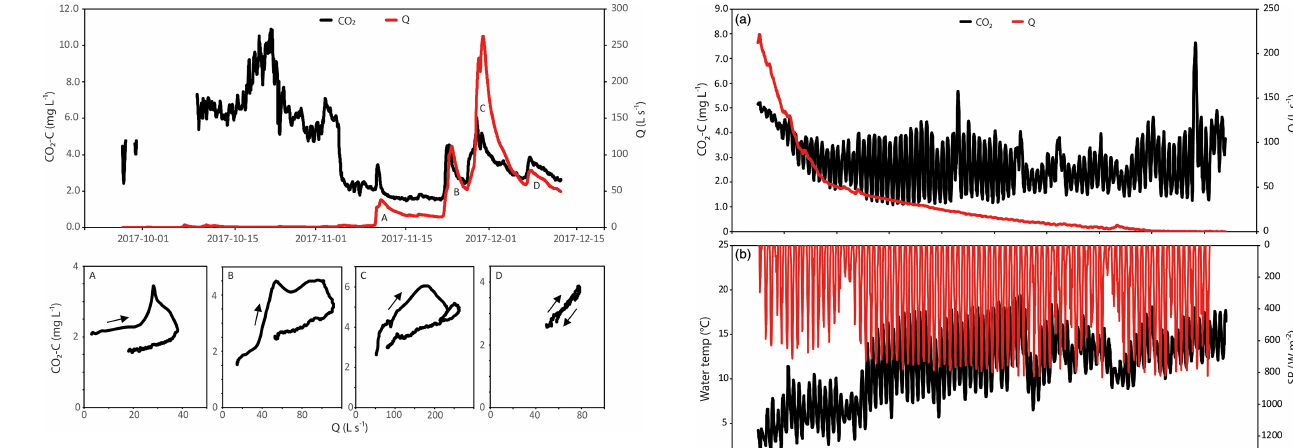
Figure 4. Stream CO 2 concentration (black) and discharge (red) for the autumn 2017 period with CO 2 – Q hysteresis plots for four rain events.